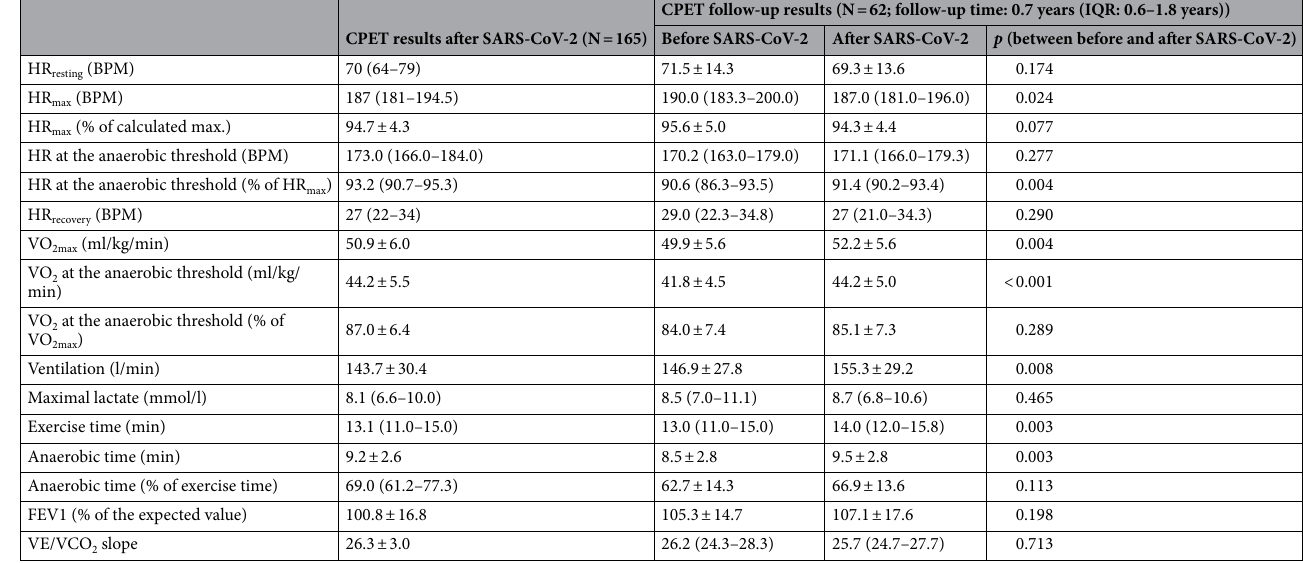
Table 1. CPET follow-up results of elite asymptomatic athletes after a SARS-CoV-2 infection. All CPET following SARS-CoV-2 infection (N = 165) and for comprehension the results before and after SARS-CoV-2 infection (N = 62). Follow-up time after the onset of the first symptoms of SARS-CoV-2 infection: 93.5 days (IQR: 66.8–130.0 days). Time between the CPET examinations before and after SARS-CoV-2 infection: 0.7 years (IQR: 0.6–1.8 years). CPET Cardiopulmonary exercise testing; SARS-CoV-2 Severe acute respiratory syndrome coronavirus 2; HR resting Resting heart rate; BPM Beats per minute; HR max Maximal heart